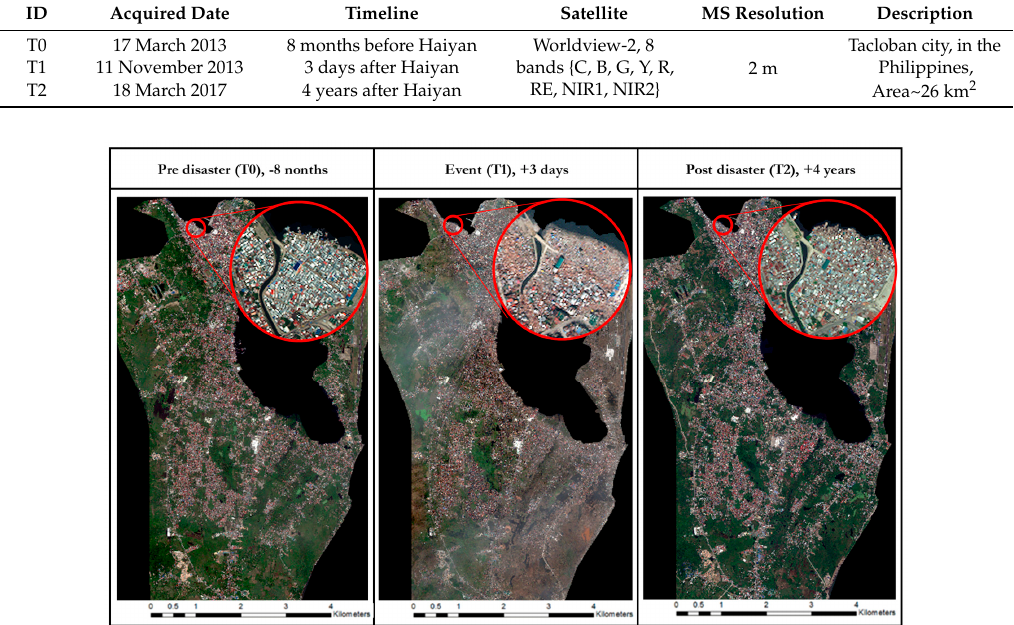
Figure 2. Three WorldView-2 images of the study area; red circles show the status of the slum areas, which were heavily devastated by Haiyan within Tacloban city.